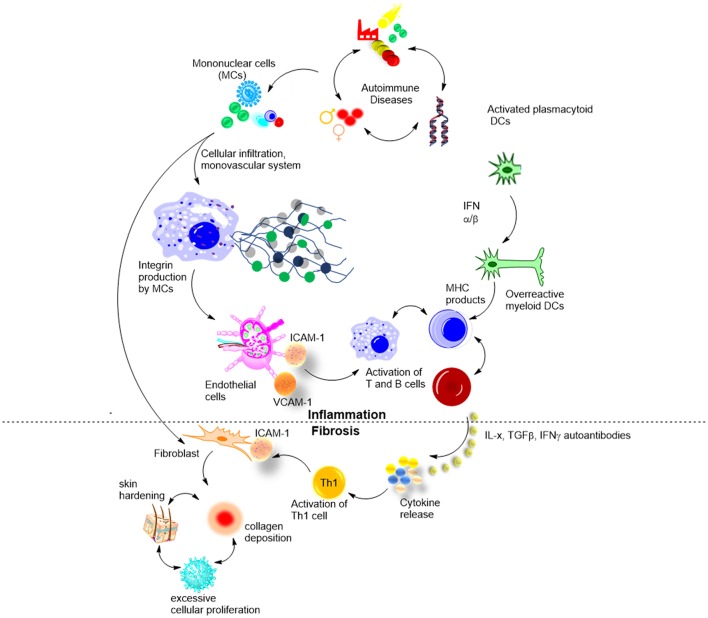
Biological mechanisms involved in morphea, and suggested roles of cytokines and autoantibodies.